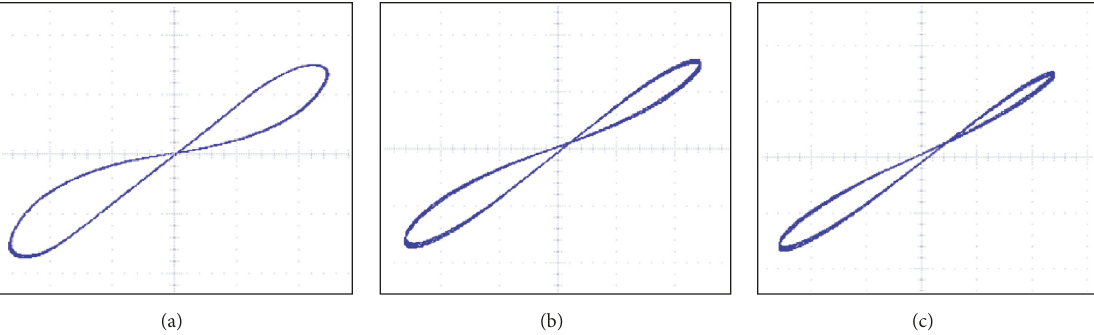
Figure 11: Experimental results of the decremental type emulator when 𝐶 1 = 𝐶 2 = 100 pF. (a), (b), and (c) represent hysteresis loops in V - 𝑖 plane operating at 10 kHz, 35 kHz, and 50 kHz, respectively. The scales are 0.2 V/div for 𝑥 -axis and 0.2 V/div for 𝑦 -axis.